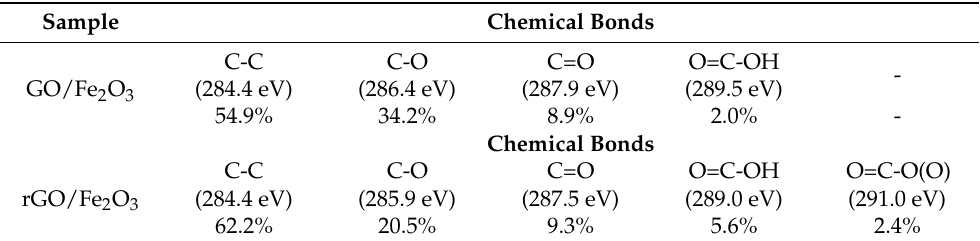
Table 1. The percent contents of C1s chemical bonds in GO/F 2 O 3 and rGO/Fe 2 O 3 samples. The results are normalized to 100% for the C1s